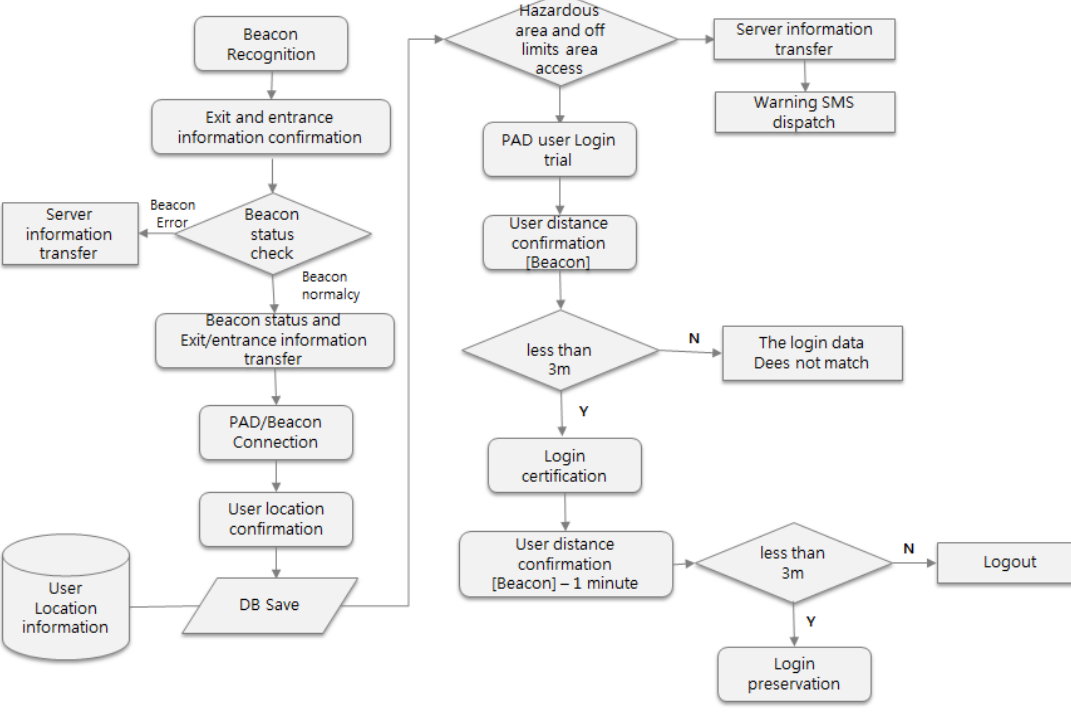
Figure 18. Algorithm for Worker’s Security Validation and Warning Mechanism.